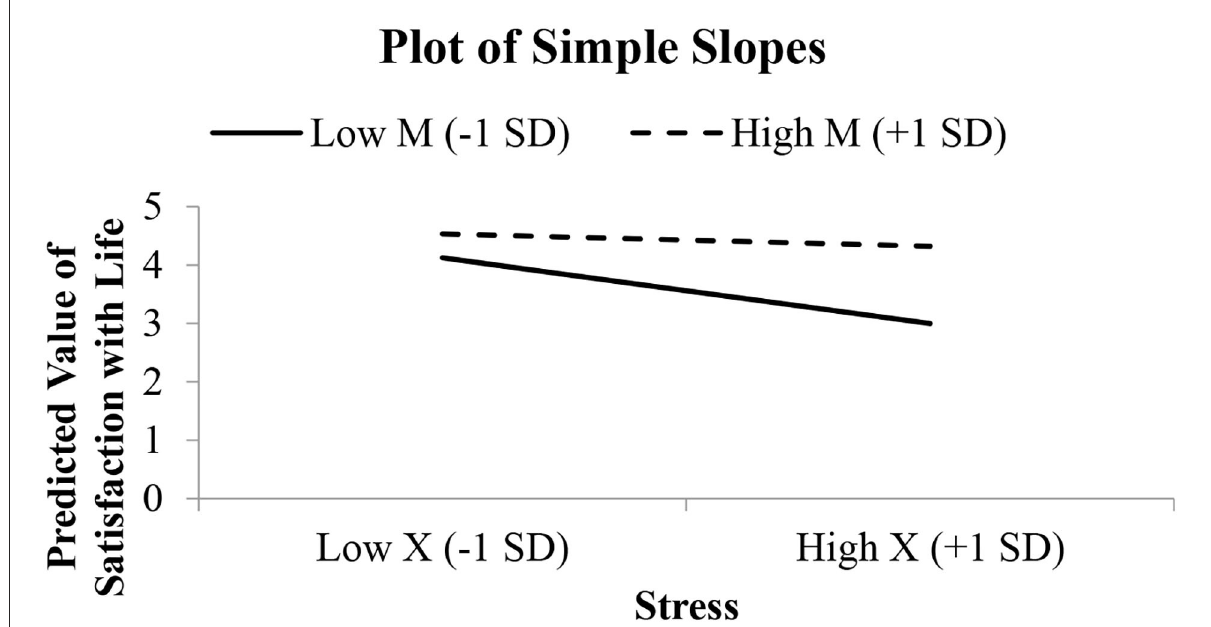
FIGURE7 Simple slope graph for the model relating satisfaction with life to stress, thwarted belongingness, and their